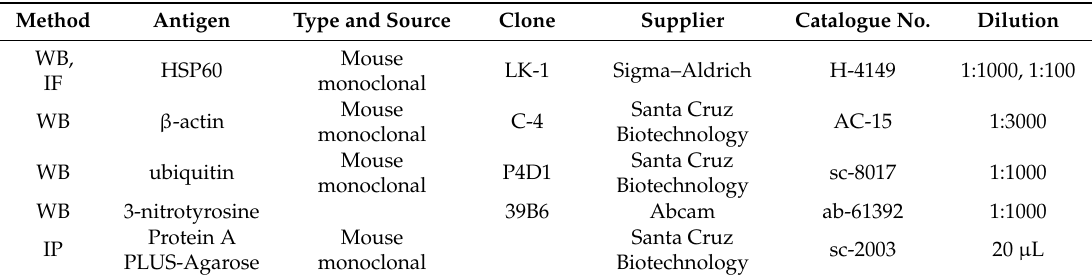
Table 1. Primary antibodies used for Western blot, immunofluorescence, and immunoprecipitation analyses.